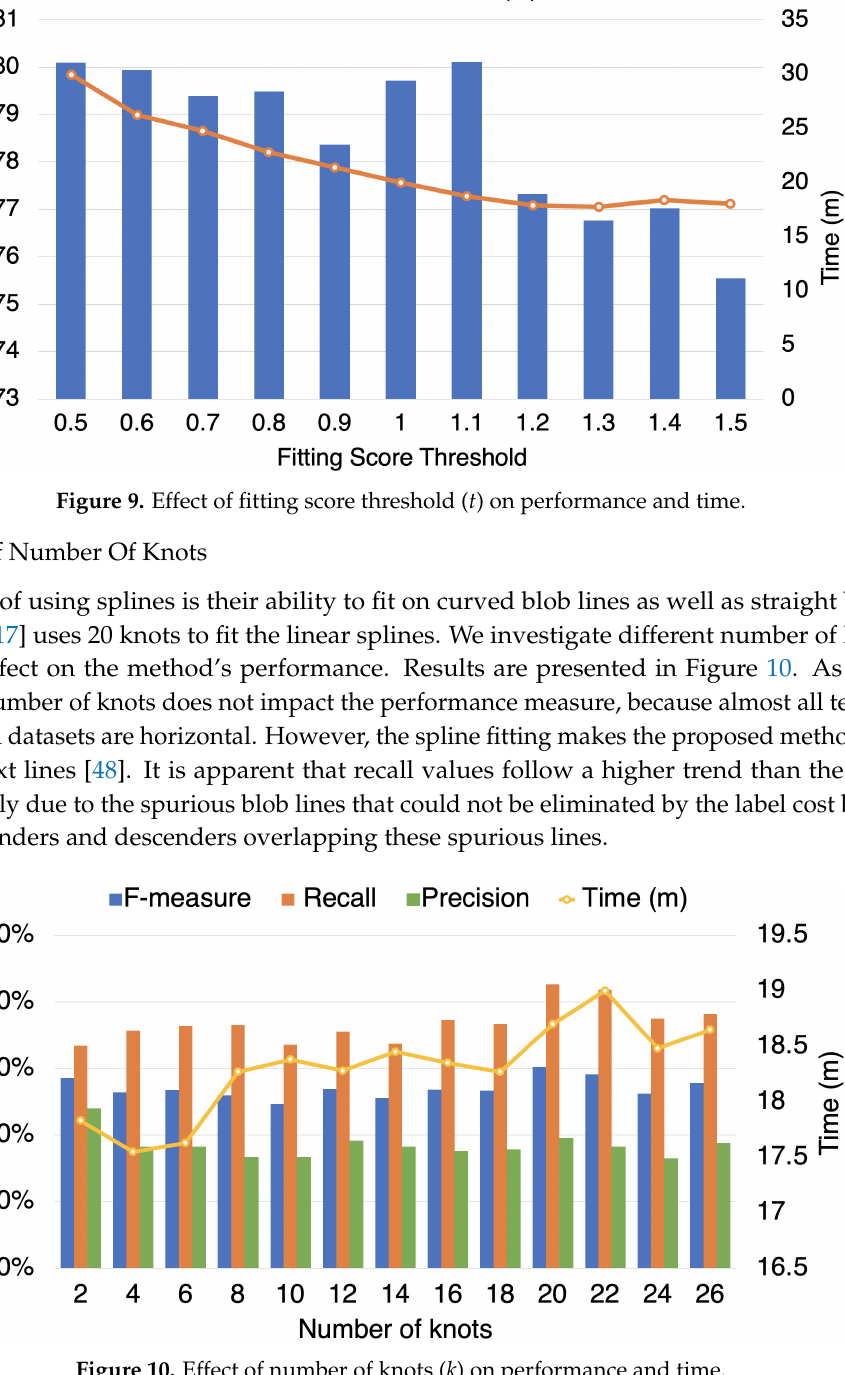
Figure 10. Effect of number of knots ( k ) on performance and